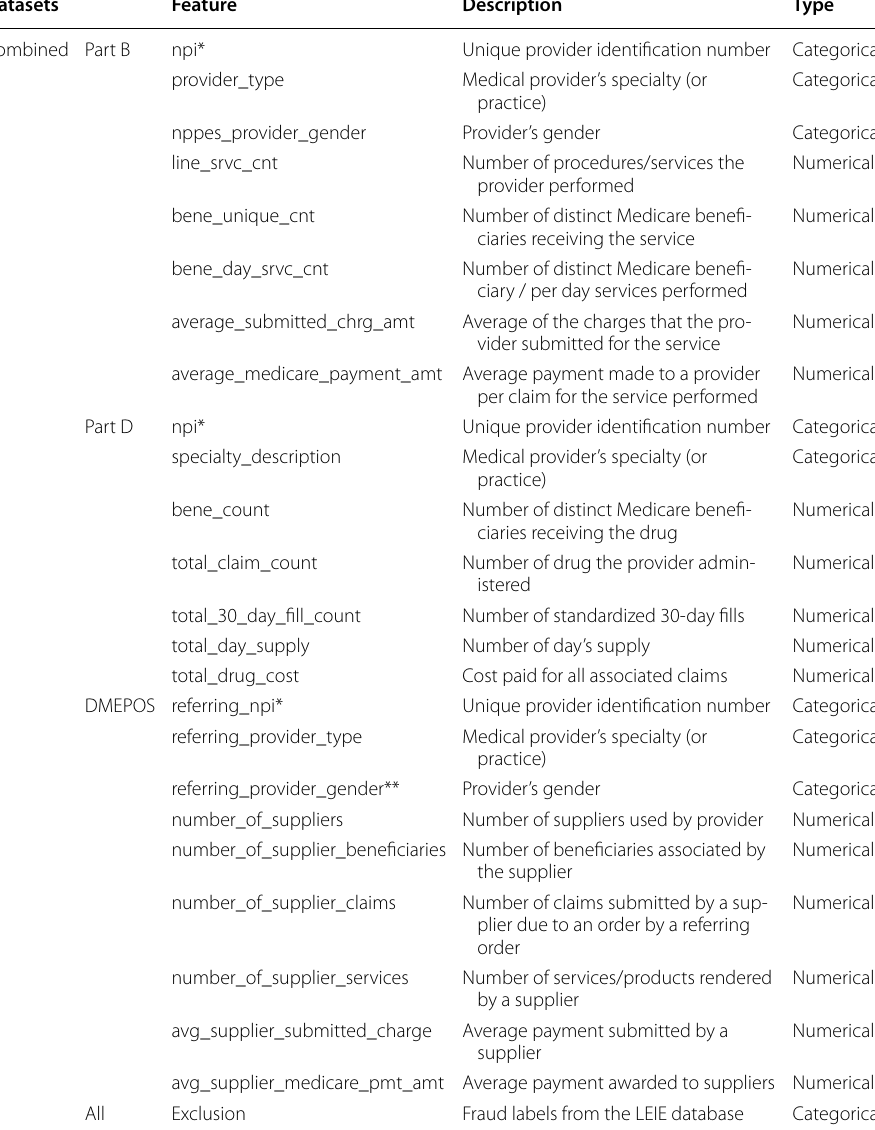
Table 1 Description of features chosen from the Medicare